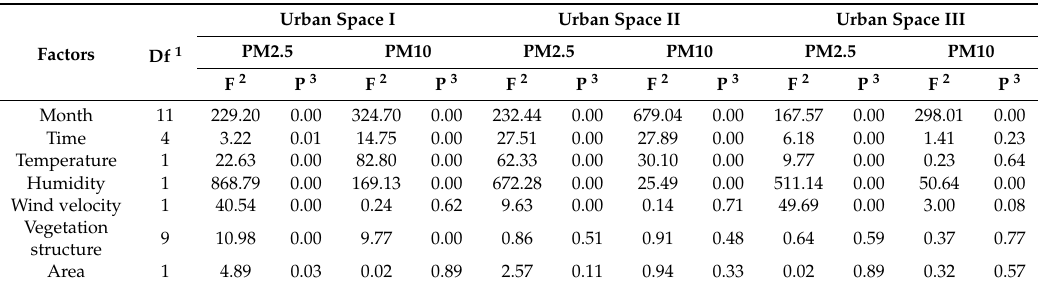
Table 5. Variance analysis of factors a ff ecting PM concentration in urban space with di ff erent green coverage